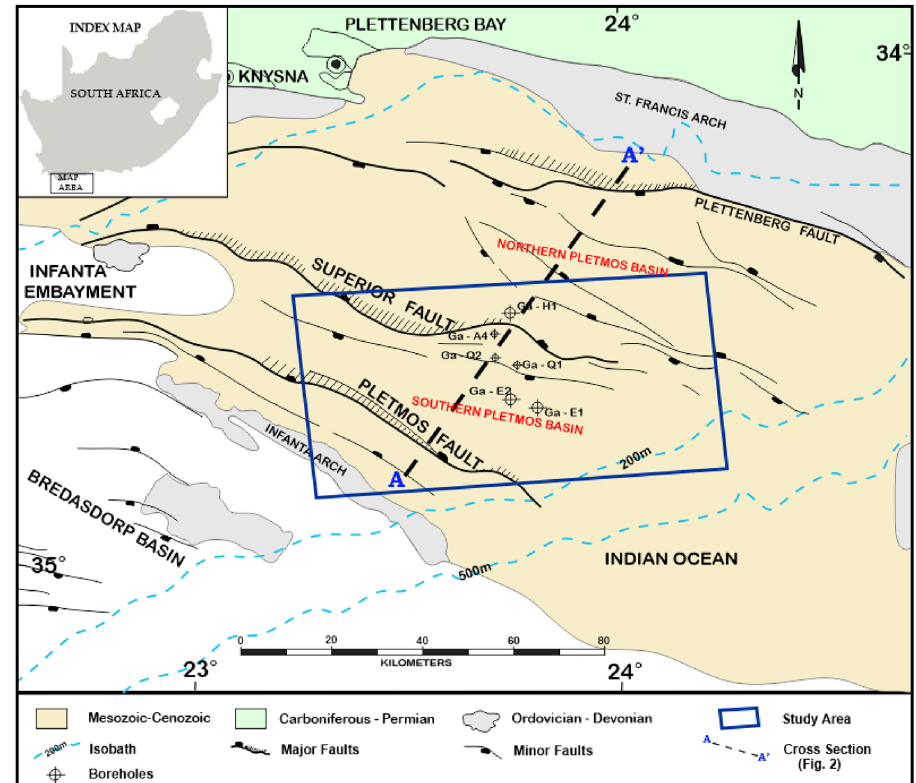
Fig. 1 The location map highlighting the approximately 1025 km 2 within the southern depocenter of the Pletmos Basin. Modified after Bate and Malan (1992) and Viljoen et al.